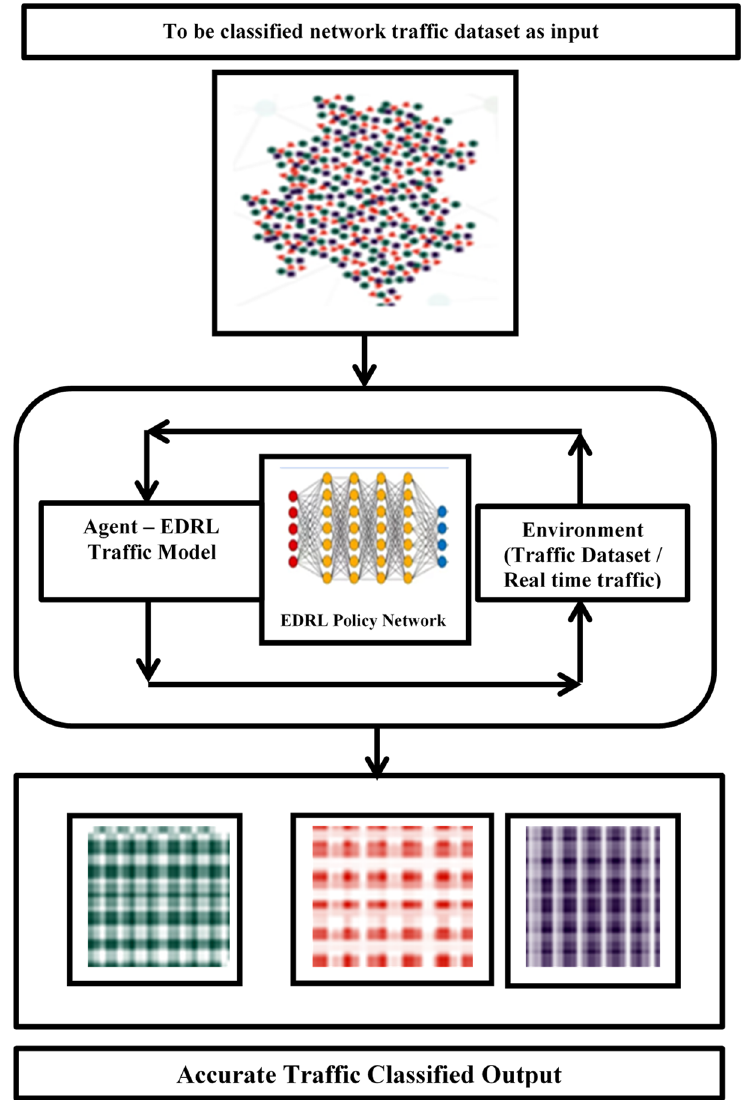
Figure 2. An EDRL architecture for network traffic analysis.